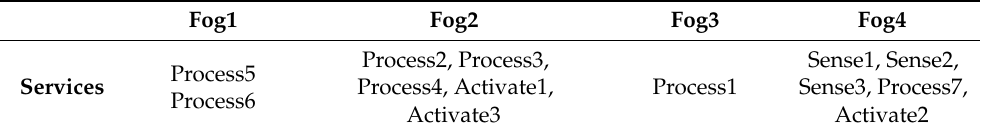
Table 5. Best service placement in the second scenario, security is prioritized over other criteria. Fog1 Fog2 Fog3 Fog4 Sense1, Sense2, Sense3, Process1, Process2 Services Process3, Process6 Process7 Activate1, Activate3